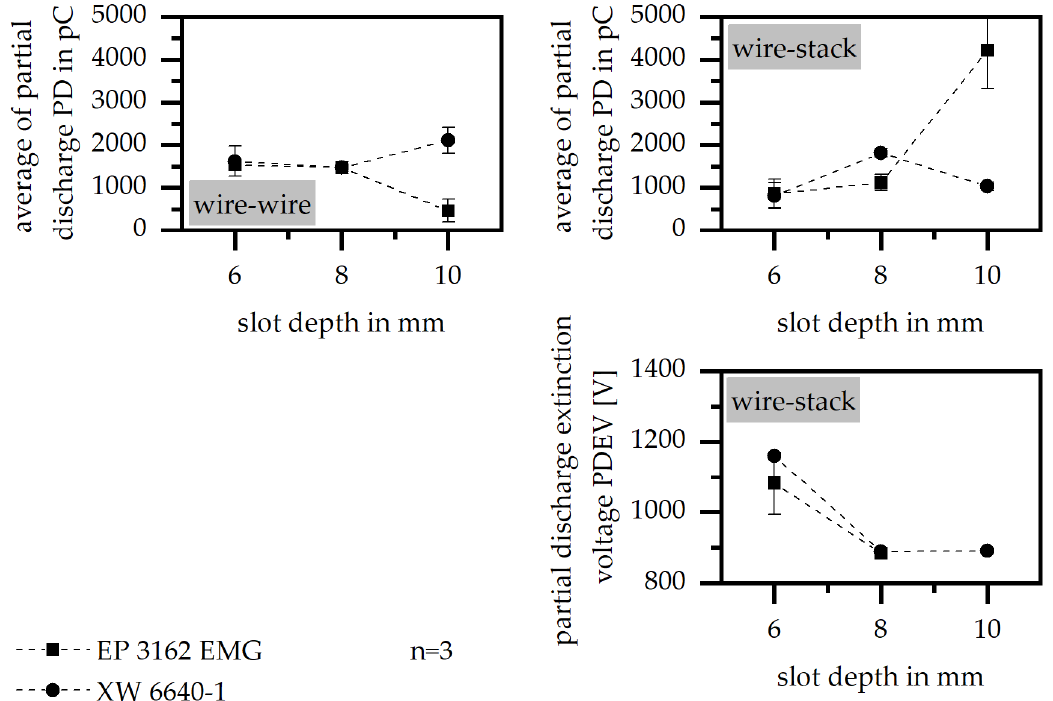
Figure 9. Average of partial discharge (PD) and partial discharge extinction voltage (PDEV) relative to the slot depth in the insulation system of wire to wire and wire to stack.